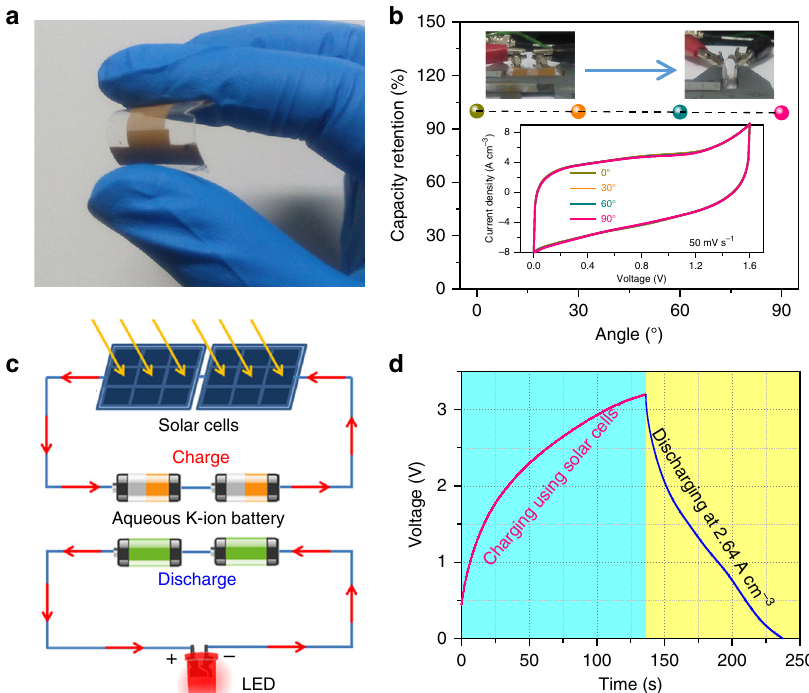
Fig. 5 Flexible all-solid-state V-Mn AR-PIMBs integrated in solar cells. a Typical photograph for fl exible all-solid-state V-Mn AR-PIMBs supported by PMMA substrates with PVA/KCl gel electrolyte. b Capacity retention of fl exible aqueous V-Mn AR-PIMBs at different macroscopic bend angles. Inset: Photographs of fl exible all-solid-state V-Mn K + -ion microbatteries bended from 0 to 90° (top) and their corresponding CV curves (bottom). c Schematic showing a self-powered system constructed with two-series fl exible V-Mn AR-PIMBs, 2 V thin- fi lm solar cells and LED lights: when sunlight is available, the V-Mn AR-PIMBs are charged by solar cells (top); when sunlight is unavailable, they are discharged to power LED lights (bottom). d Typical charge/ discharge curves for the charged process powered by solar cells and the discharge process at a current density of 2.64 A cm −